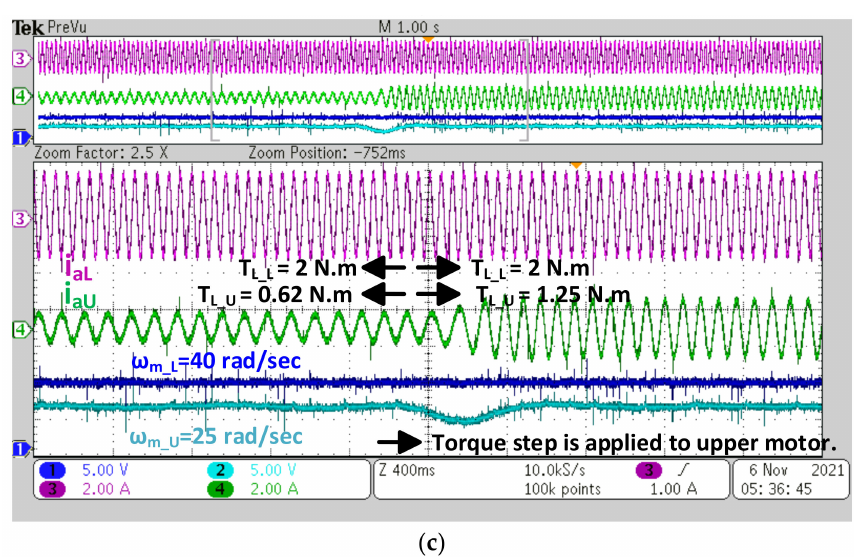
Figure 10. Experimental waveforms for speeds ( ω m_U and ω m_L ) and one-phase stator currents ( i aU and i aL ) for each machine under the applied torque steps. Scope channel 1: Lower machine speed, ω m_L , is 40 rad/s. Scope channel 2: Upper machine speed, ω m_U , is 25 rad/s. Scope channel 3: Lower machine stator current, i aL . Scope channel 4: Upper machine stator current, i aU . The speed scale is 20 rad/s per division. The current scale is 2 A per division. ( a ) Torque steps of 2 N · m and 1.25 N · m are applied to the lower and upper machines, respectively. ( b ) A torque step of 2 N · m is applied to the lower machine while the upper machine is operated under a fixed torque of 1.25 N · m. ( c ) A torque step of 1.25 N · m is applied to the upper machine while the lower machine is operated under a fixed torque of 2 N ·